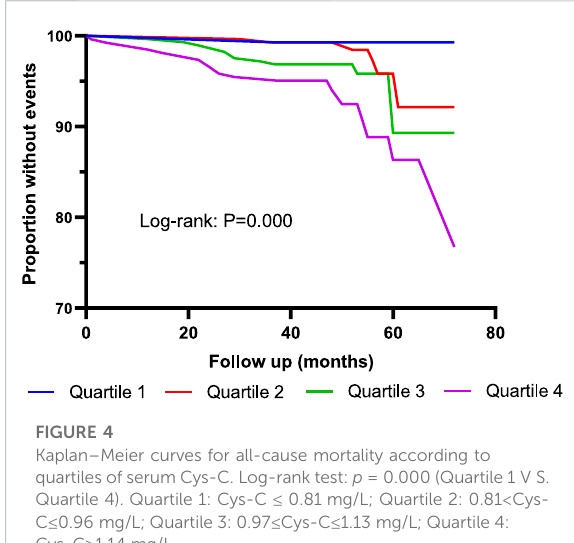
atherosclerosis.